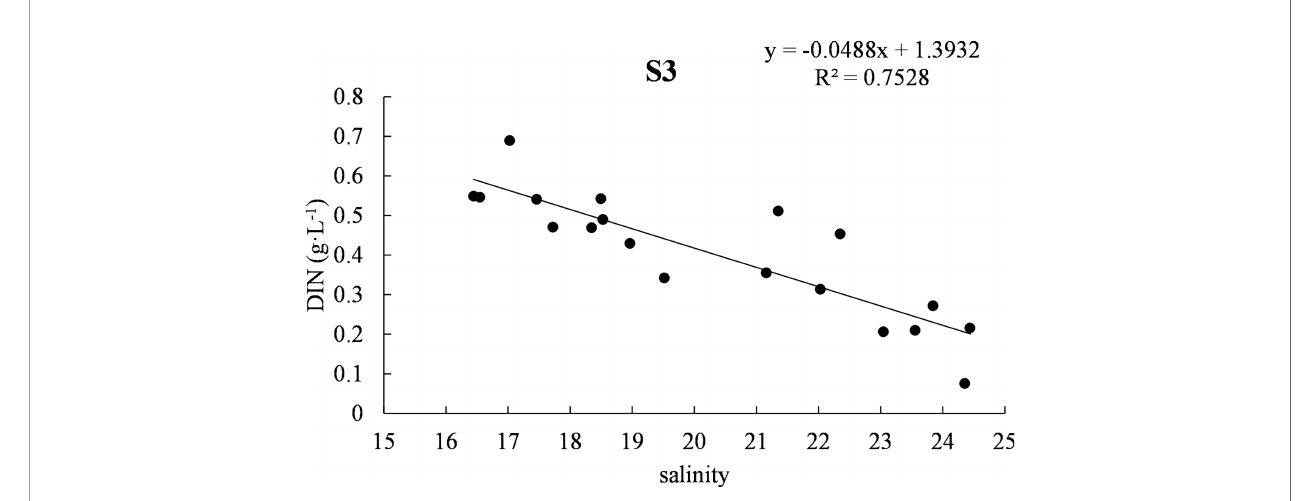
FIGURE 6 | Scatter diagrams of the salinity and DIN at S3 from July 26 to August 16,